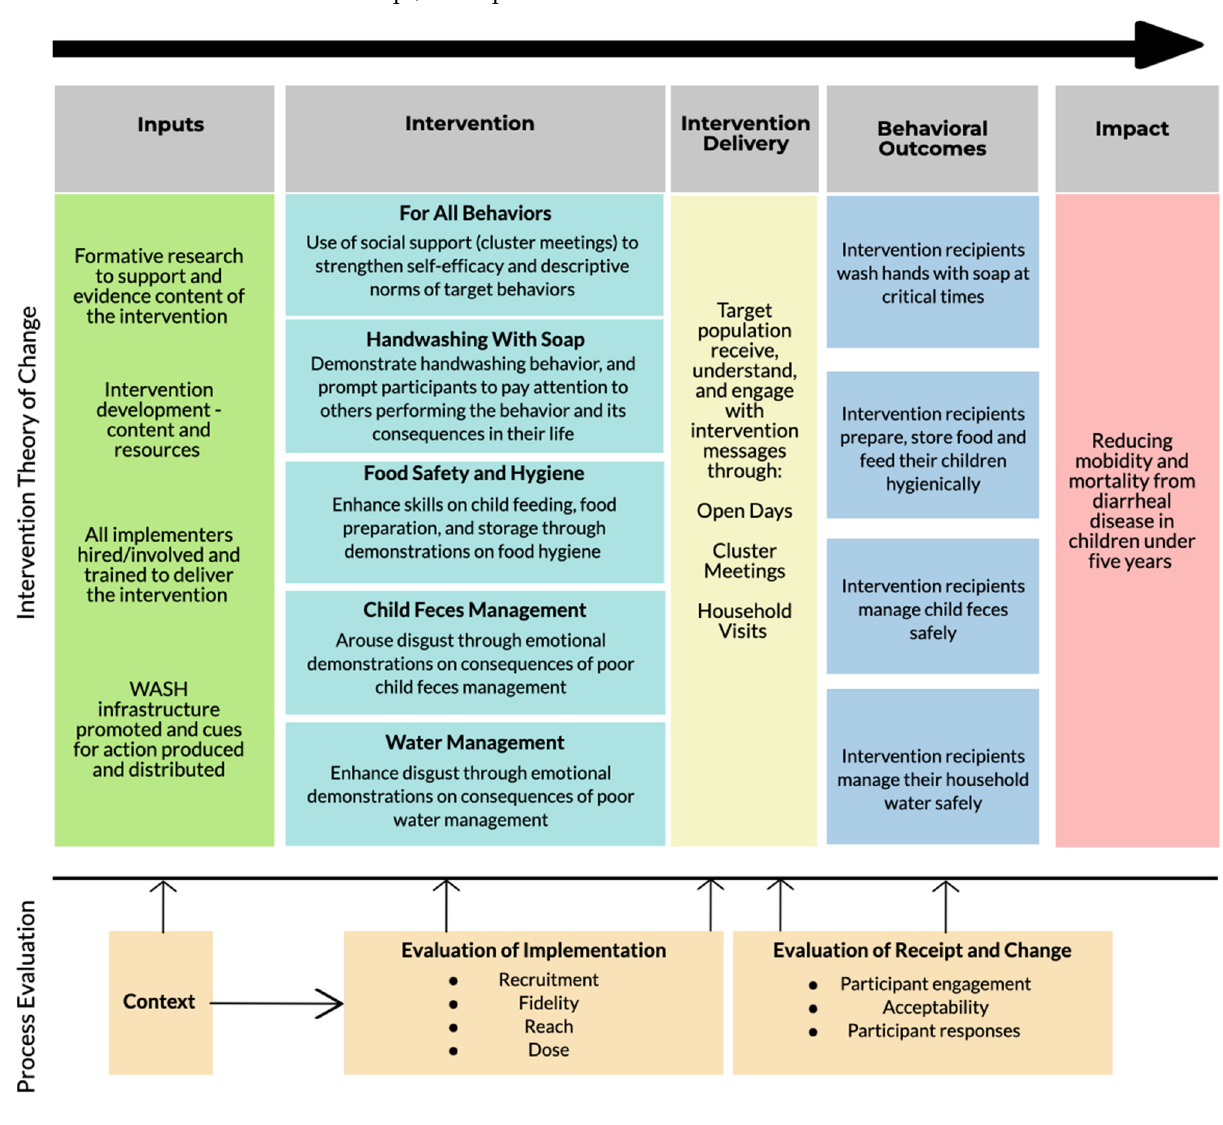
Figure 2. Process evaluation